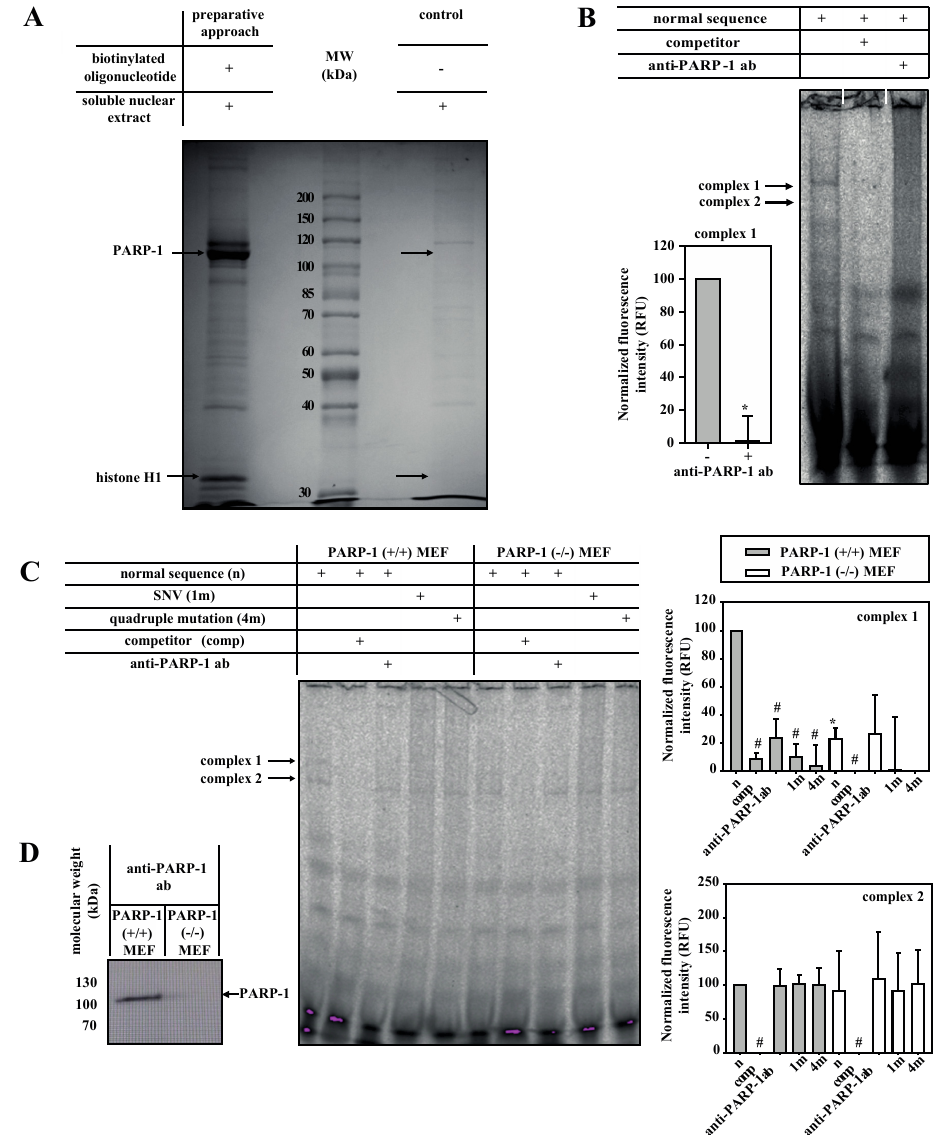
Figure 2. PARP-1 and H1 bind to the wild-type aromatase promoter I.3 / II region. ( A ) PARP-1 (110 kDa) and histone H1 (32 kDa) were purified by DNA-affinity pull-down from soluble nuclear extract of 3T3-L1 cells using biotinylated wild-type oligonucleotide. Specifically binding (left) and non-specifically binding (right) proteins were separated by SDS-PAGE and detected by Coomassie Blue staining. Proteins identified by mass spectrometry are indicated by arrows (see also Supplementary Materials, Figure S2). MW, molecular weight. ( B ) Complex 1 from soluble nuclear extracts from 3T3-L1 cells was inhibited by competitor and anti-PARP-1 antibodies (ab) ( n = 4; * p < 0.05). ( C ) Soluble nuclear extracts from PARP-1 wild-type ( +/+ ) MEFs or PARP-1 knock-out ( − / − ) MEFs were used for EMSAs. Complexes 1 and 2 were inhibited by the competitor, but only complex 1 formation was suppressed when using SNV (1m)- or quadruple mutation (4m)-containing probes. Furthermore, the formation of complex 1 was inhibited by anti-PARP-1 antibodies and was strongly reduced in PARP-1 ( − / − ) MEFs ( n = 3; * p < 0.05 for ( − / − ) versus ( +/+ ); # p < 0.05 for treatments compared with corresponding normal sequence treatment). ( D ) Western blot detects no PARP-1 in PARP-1 knock-out